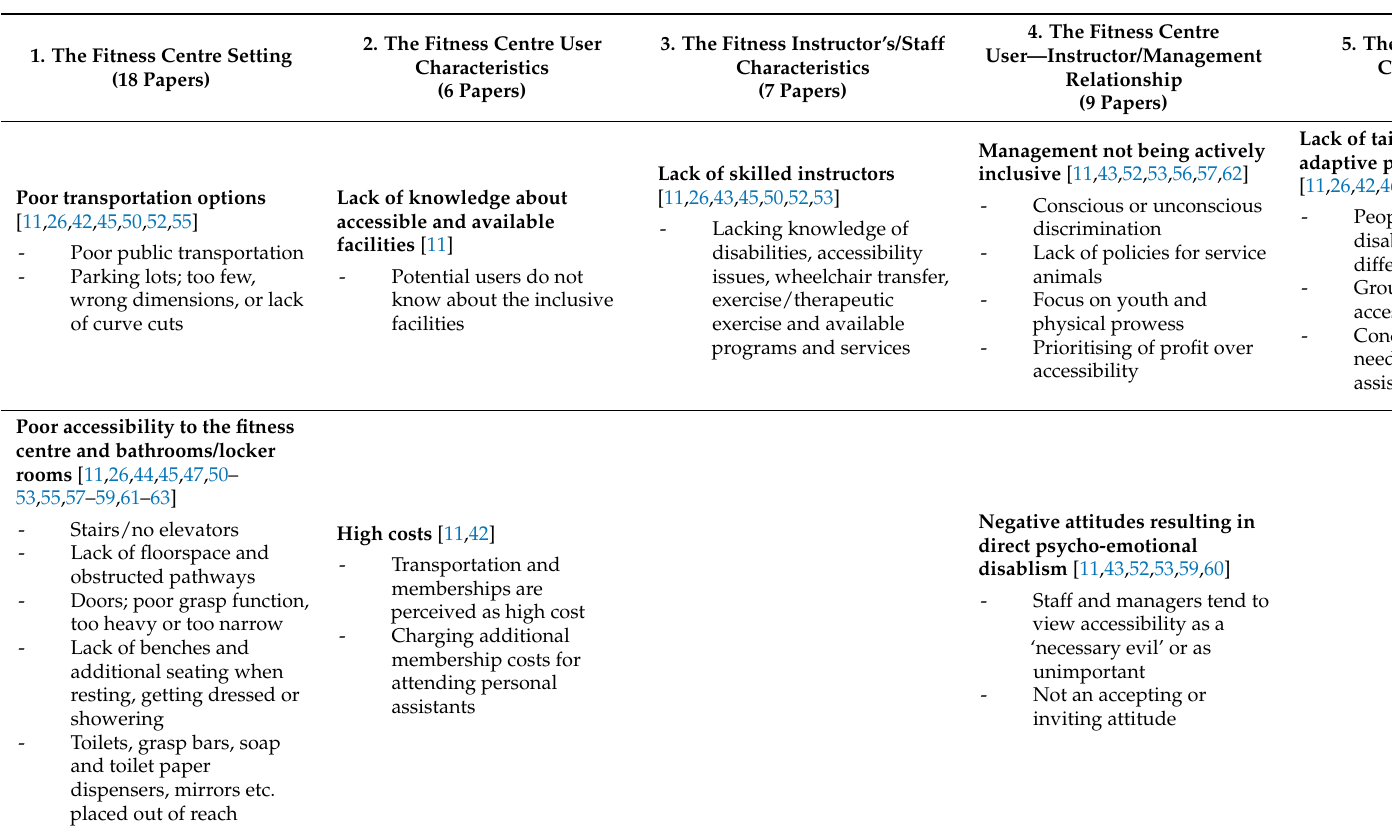
Table 3. Barriers to exercising for adults with physical disabilities (AwPD) distributed across the six modified context factor categories. Numbers in parentheses in the coloured cells refer to the total number of different papers (references in the square brackets) informing each of the six